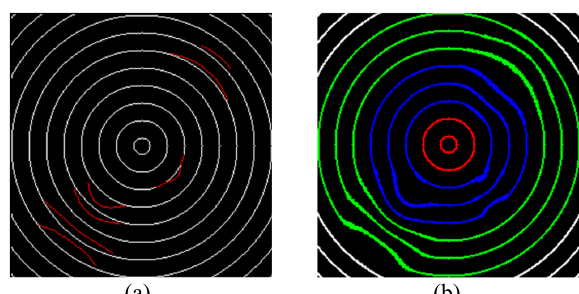
Fig. 6. The processed distortion images are (a) the difference image with marked distortions, and (b) the marked difference image based on three different severity levels of distortion Fig. 6(b) shows that the marked difference image is divided into three areas based on three different severity levels of distortion: the red part is the low-tolerance region, which consists of the 1st and 2nd circles, called area A; the blue part is the medium-tolerance region, which is composed of the 3rd, 4th, and 5th circles, called area B; the green part is the high- three areas are input into the inference system for inference and classification.